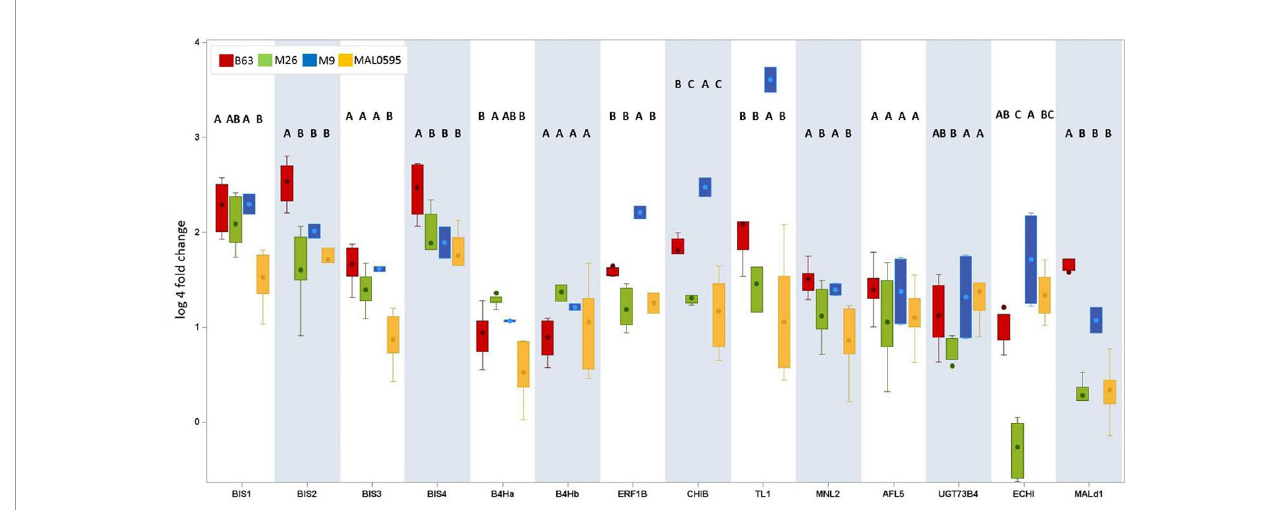
FIGURE 5 | Genotypic differences in the regulation of the 14 CGs. This box plot presents only CGs with an upregulation (fold change ARD soil/ g ARD soil > 4.5) in root tissue. The root-speci fi c average fold change values of all genotypes including fi ve (B63, M26, MAL0595) or two replicates (M9), respectively, of 14 genes after cultivation in Heidgraben ARD soil are shown. The letters denote the signi fi cant differences between the genotypes for one gene. Signi fi cant differences are indicated by different letters. The whiskers were not drawn to the minimum or maximum values, if they were longer than 1.5 times the IQR. Data points outside of this range of 1.5 × IQR were indicated as outliers